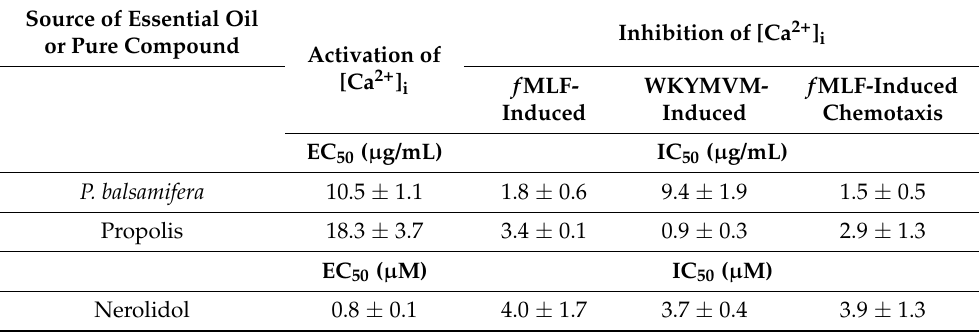
Table 2. The effect of nerolidol and essential oils from propolis and P. balsamifera buds on human neutrophil [Ca 2+ ] i and